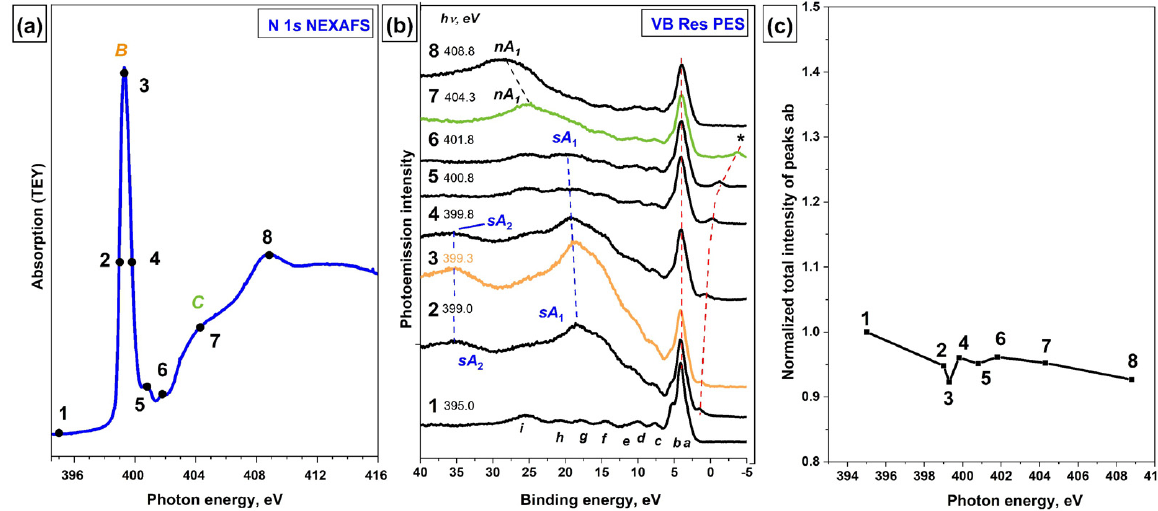
Figure 5. ( a ) N 1s NEXAFS spectrum, the photon energies used to excite the VB PE spectra are marked with numbered dots; ( b ) a series of resonant VB PE spectra of the [Ni(Salen)] complex and ( c ) the total intensity of the a-b bands depending on the energy of exciting photons in the vicinity of the N 1s absorption edge ( h ν = 395–408.8 eV) of the [Ni(Salen)] complex. In ( b ), the N 1s PE line resulting from the absorption of synchrotron radiation reflected by the diffraction grating in the second order is marked with an asterisk (*). The total intensity of the PE bands a-b at different photon energies was normalized to their intensity at h ν = 395 eV (non-resonant excitation).